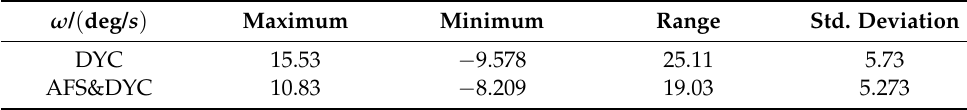
Table 4. Yaw rate under high-speed conditions.